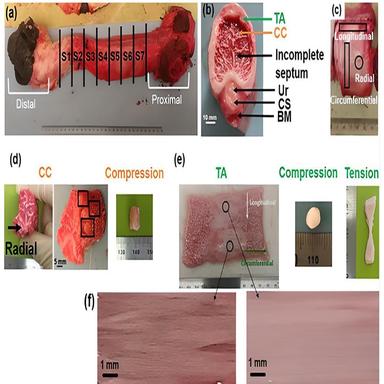
(a) Horse penile shaft showing the distal and proximal sections (after removal of the surrounding fat, skin and unwanted tissues, S-represents the position where whole penis was obtained from), (b) Cross-section of horse penis, (c) The penile shaft is segmented into 30 mm lengths for whole organ testing (rectangular box represents the position from which dog-bone specimens were obtained and the circular stamp shows the position of radial specimens). The whole organ was segregated into (d) CC for compression